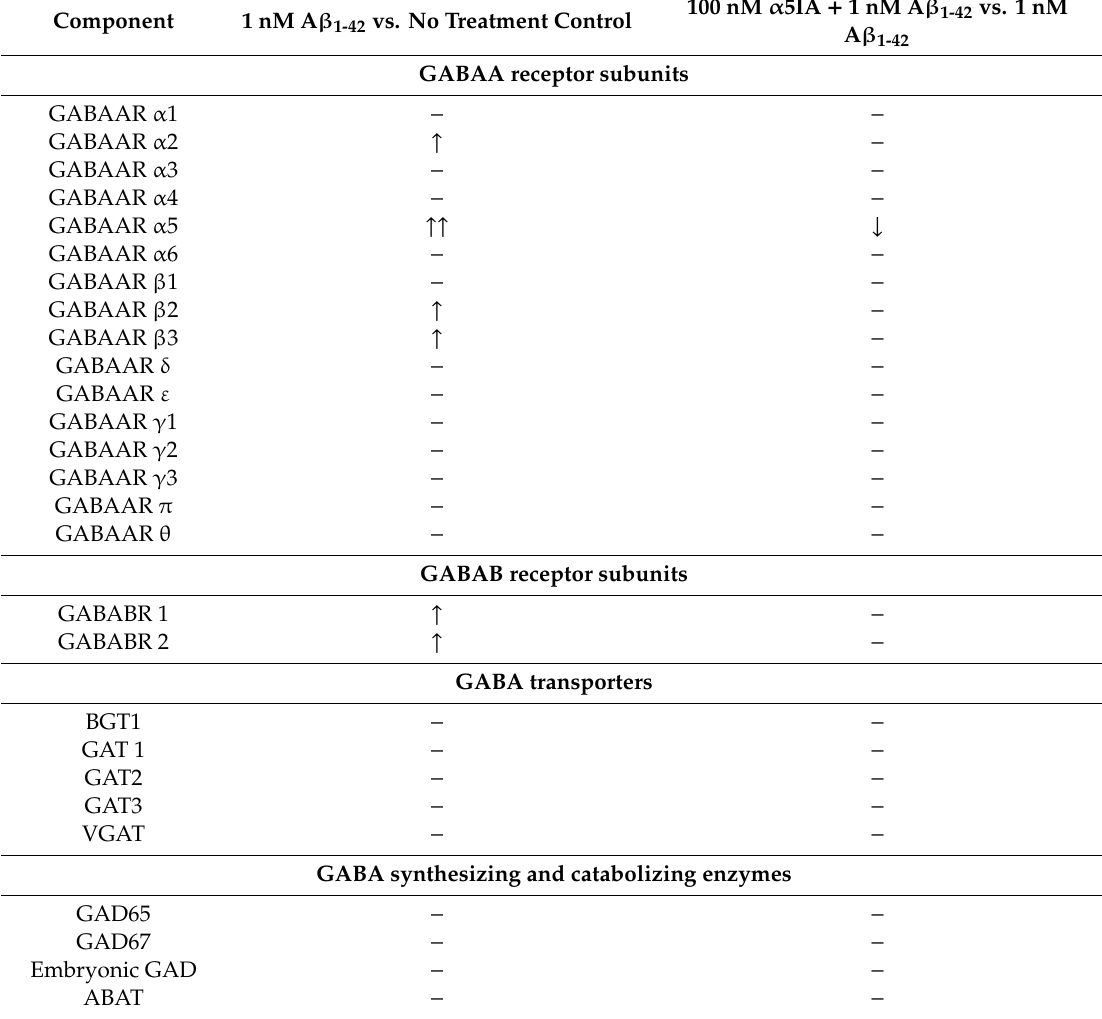
Table 1. Summary of changes in expression of GABAergic signaling components in mouse primary hippocampal cultures following treatment with 1 nM A β 1–42 and / or 100 nM α 5IA.